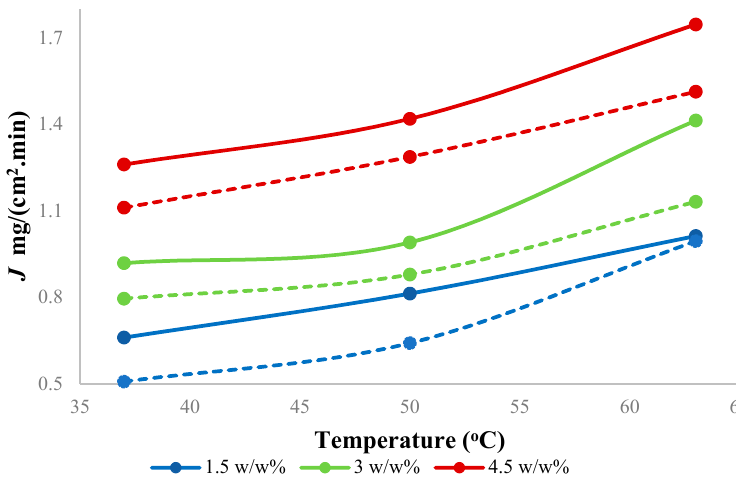
Figure 7. Effect of feed concentration on total flux using hybrid PTMSP membrane at different temperatures. Solid lines represent a hybrid PTMSP membrane, and dotted lines represent a neat PTMSP membrane. Data for pure PTMSP were taken from the literature [26].